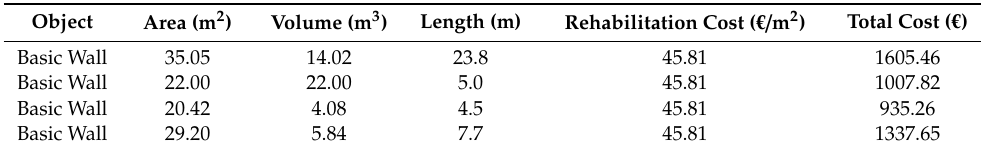
Table 4. Budget based on correct modeling.